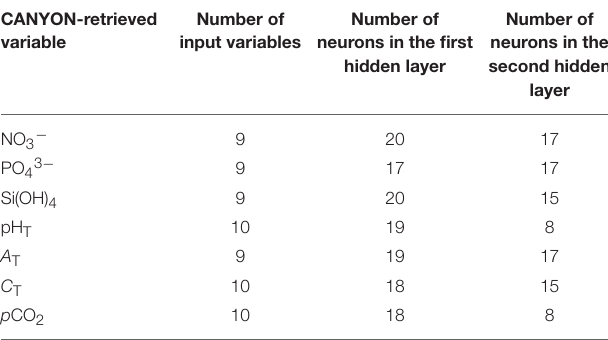
TABLE 2 | Characteristics of the Multi-Layered Perceptron architecture for each CANYON-retrieved variable. CANYON-retrieved